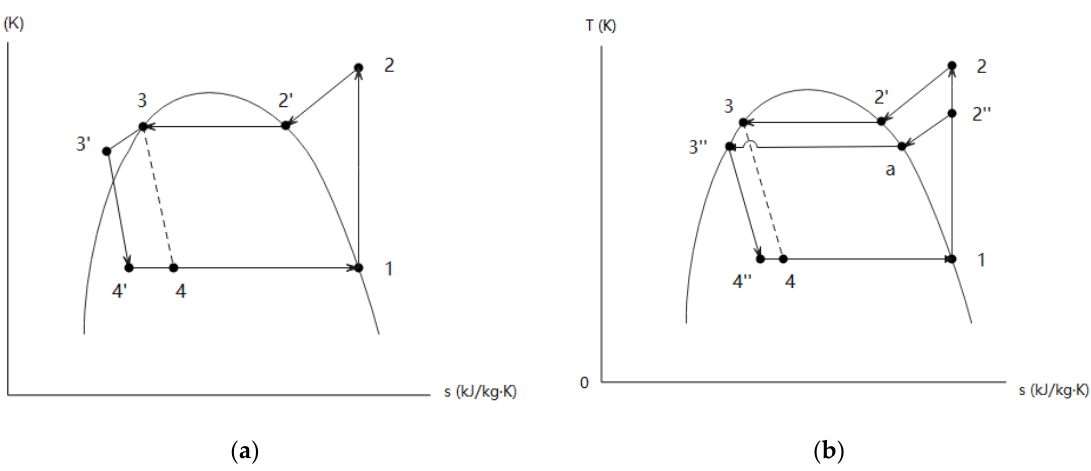
Figure 5. TDT-RAC cycles (T-s diagram) with: ( a ) fixed speed compressors (1 → 2 → 3 ′ → 4 ′ → 1); ( b ) variable speed compressors (1 → 2 ″ → 3 ″ → 4 ″ → 1).